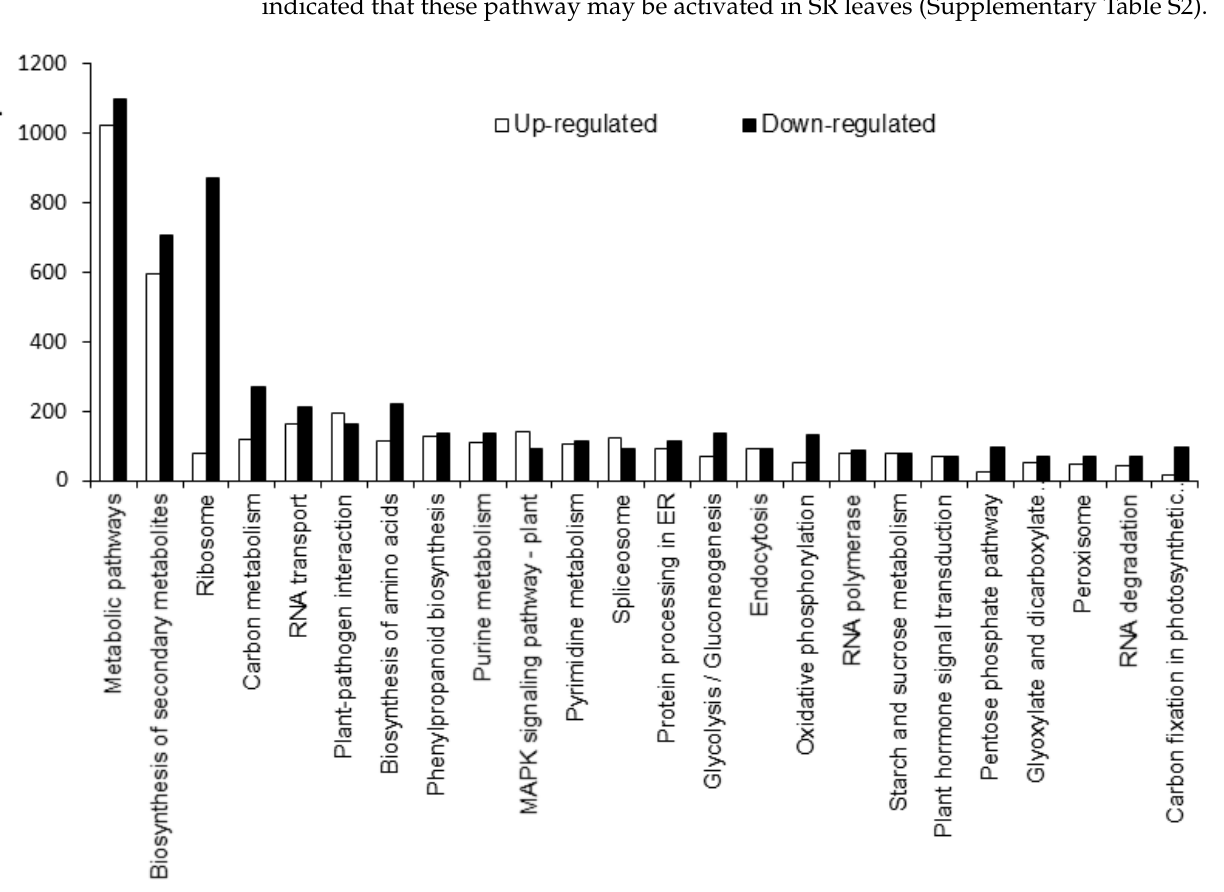
Figure 2. Various pathways and number of differentially expressed transcripts (DETs) identified by KEGG (Kyoto Encyclopedia of Genes and Genomes) Enrichment analysis. DETs in each pathway were separated as up- and down-regulated to estimate the overall activity of pathway as activated or repressed.